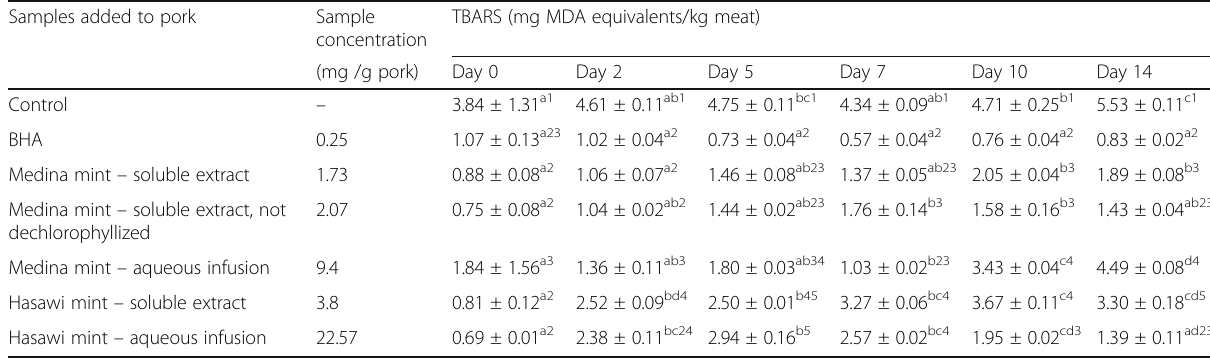
Table 3 Antioxidant activity of mint extracts determined through the measurement of TBARS in a cooked meat system 1 Samples added to pork